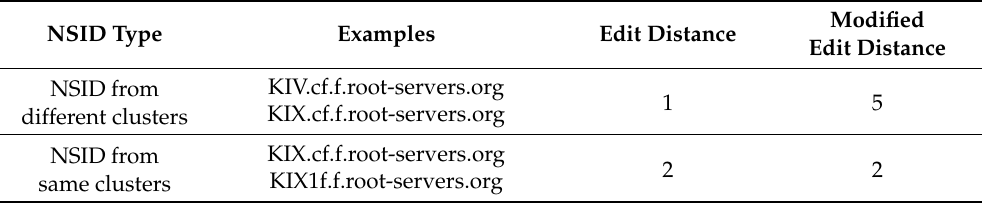
Table 1. Two pairs of NSID (F root) measured by different